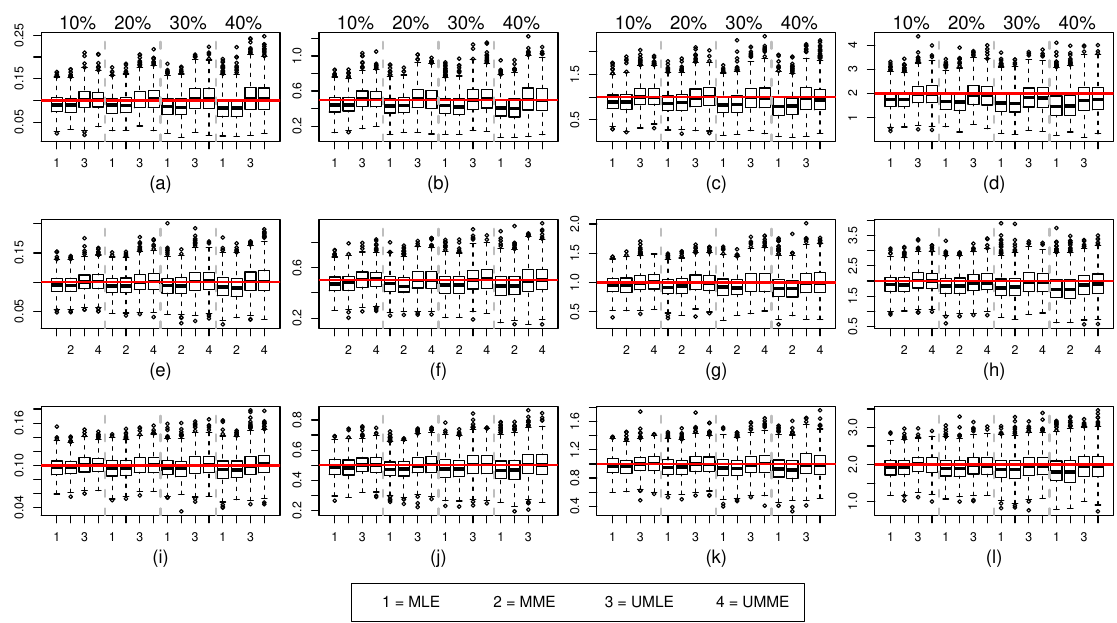
Figure 1. Sampled α values for n = 10 (top panel), n = 20 (middle panel), and n = 30 (bottom panel) for various censoring percentages. The true value of α is denoted by red colored solid line. α = 0.1 in ( a , e , i ), α = 0.5 in ( b , f , j ), α = 1.0 in ( c , g , k ), and α = 2.0 in ( d , h , l